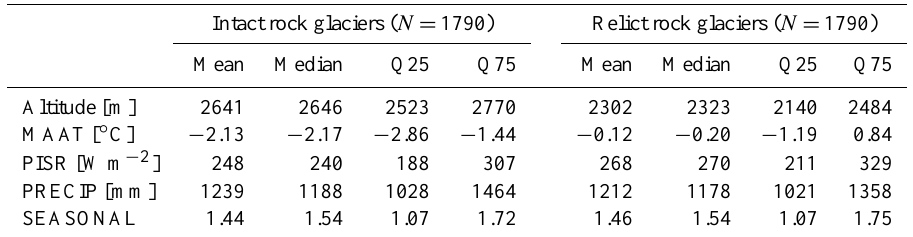
Fig. 3. Scatterplots illustrating the relation of MARST to MAAT (top left) and of the difference between MARST and MAAT to PISR (top right) for the 57 MARST values. In the lower panels, the model residuals (mean = 0 ◦ C, standard deviation = 1.52 ◦ C) of the rock model are plotted against PRECIP and SEASONAL to visualize possible relations of these two variables. Table 2. Summary statistics of the randomly sampled points representing potential explanatory variables for the debris model (Q25 lower quantile, Q75 upper